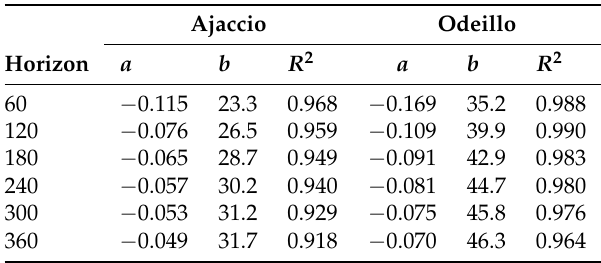
Table 2. Fitting results for Ajaccio and Odeillo, horizons 1 to 6 h.